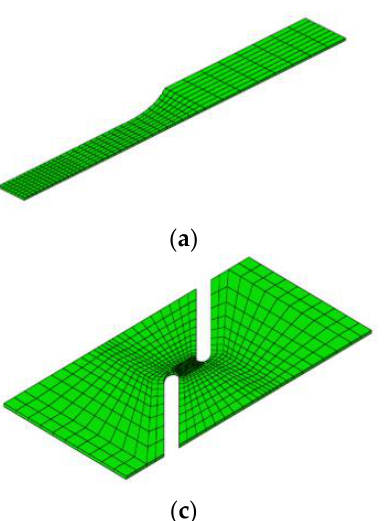
Figure 6. The finite element model: ( a ) the dog-bone specimen; ( b ) the specimen with a central hole; ( c ) the in-plane shear specimen; ( d ) the boundary conditions of the in-plane shear specimen.